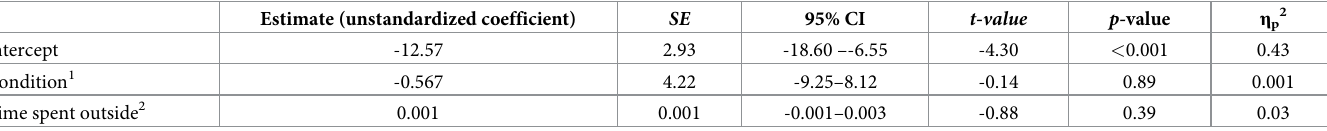
Table 5. Statistics ANCOVA; effect of the intervention on change in serum 25(OHD) from baseline to Week 8. Estimate (unstandardized coefficient) SE 95% CI